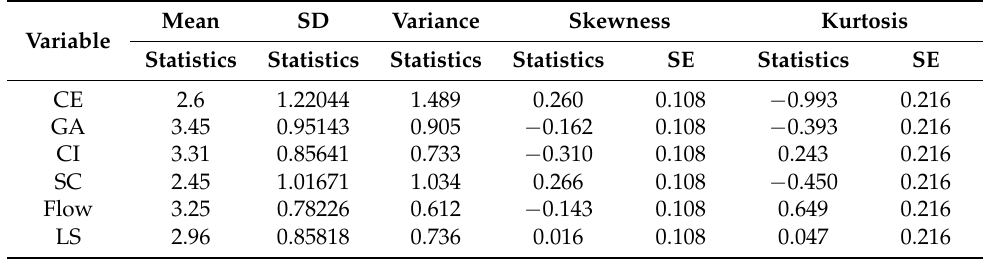
Table 3. Descriptive statistics on variables.